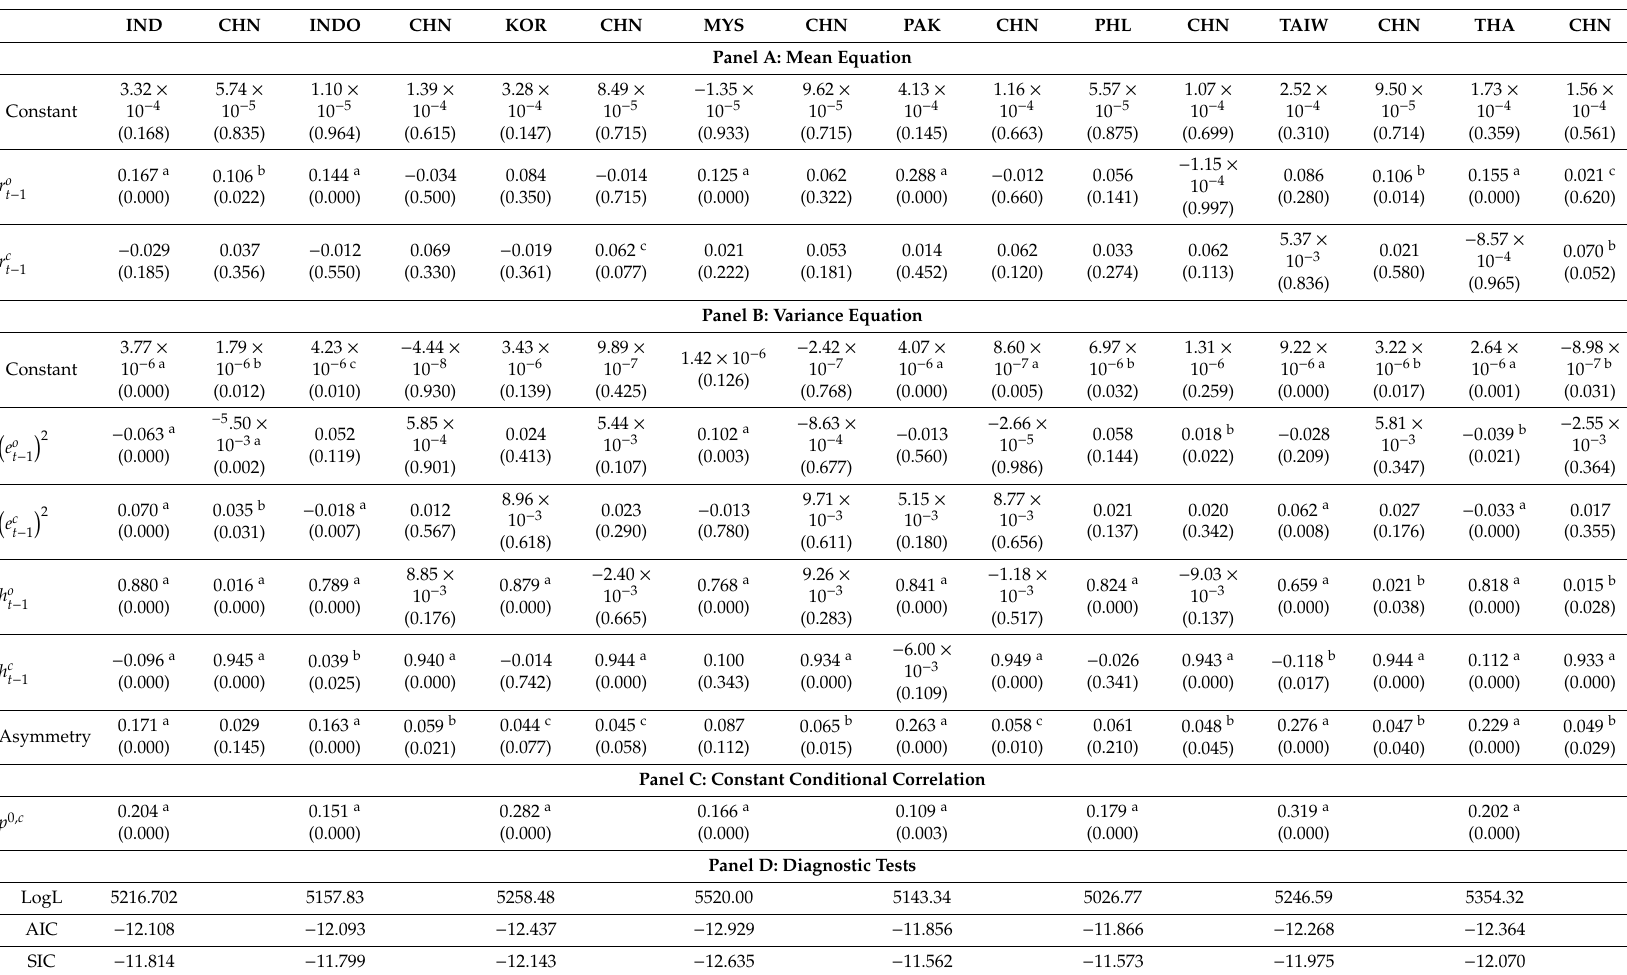
Table 7. Estimates of bivariate VAR − AGARCH for Chinese and Asian stock markets during the Chinese Stock Market